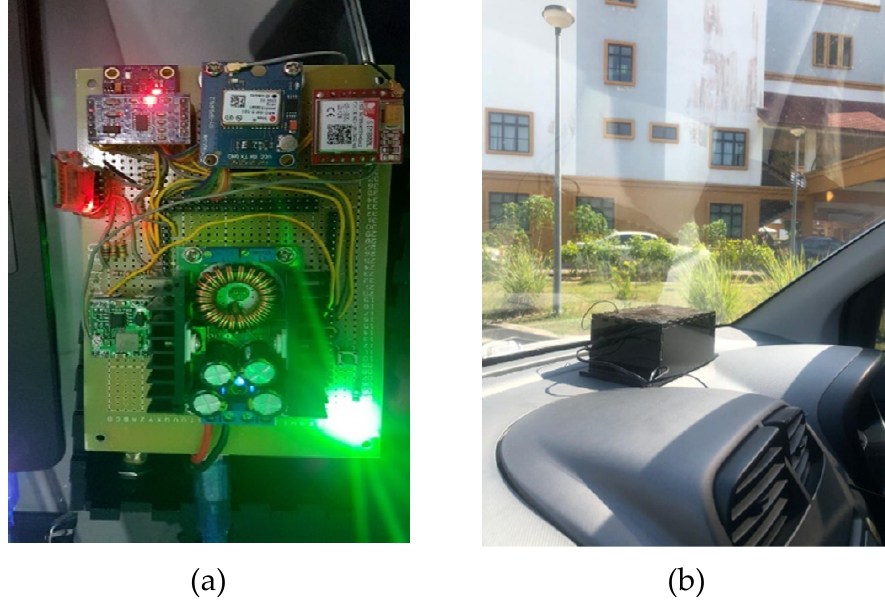
Figure 5. ( a ) Internal looks of an embedded system; ( b ) embedded system in a vehicle.